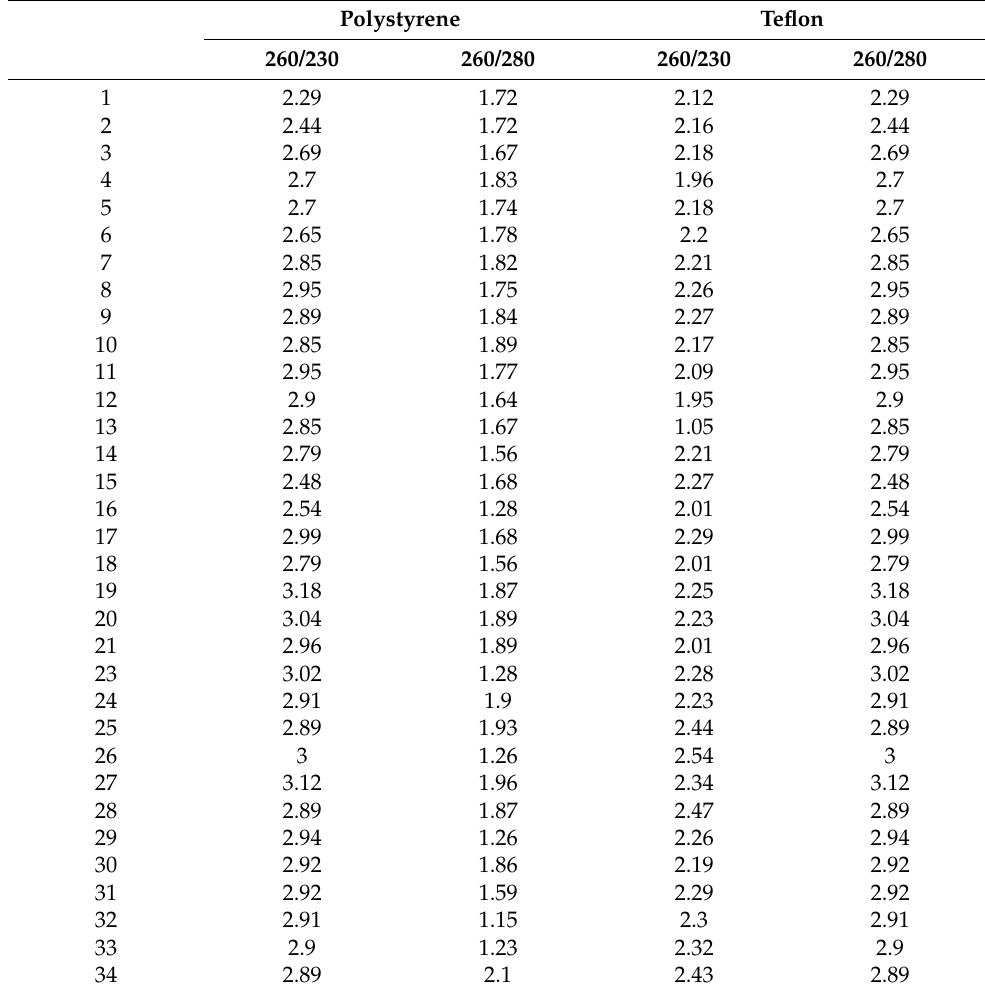
Table A1. The contamination data analysis related to DNA retrieval from various substrates including PETTE, PDMS, Polystyrene, and glass with 35